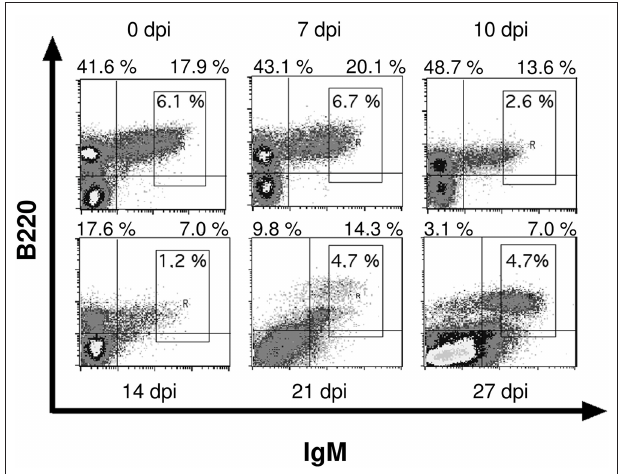
FIGURE 3 | Infection with T. cruzi leads to reduced numbers of immature B cells in bone marrow. C57BL/6 mice were infected with 75 T. cruzi blood trypomastigotes i.p. (infections with 500 T. cruzi blood trypomastigotes show comparable results). At different time points, bone marrow immature B220 +